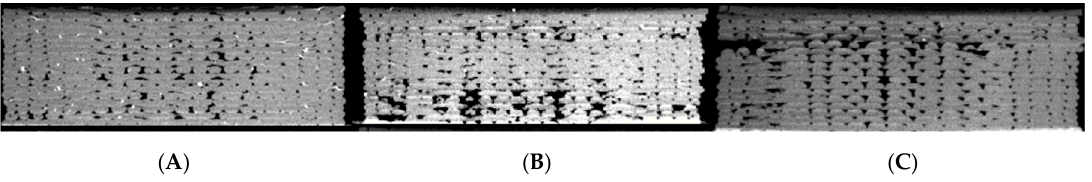
Figure 9. Microstructural cross section of 3D-printed HPMC cylinders via µ CT ( A ) HPMC15, ( B ) HPMC35, ( C )